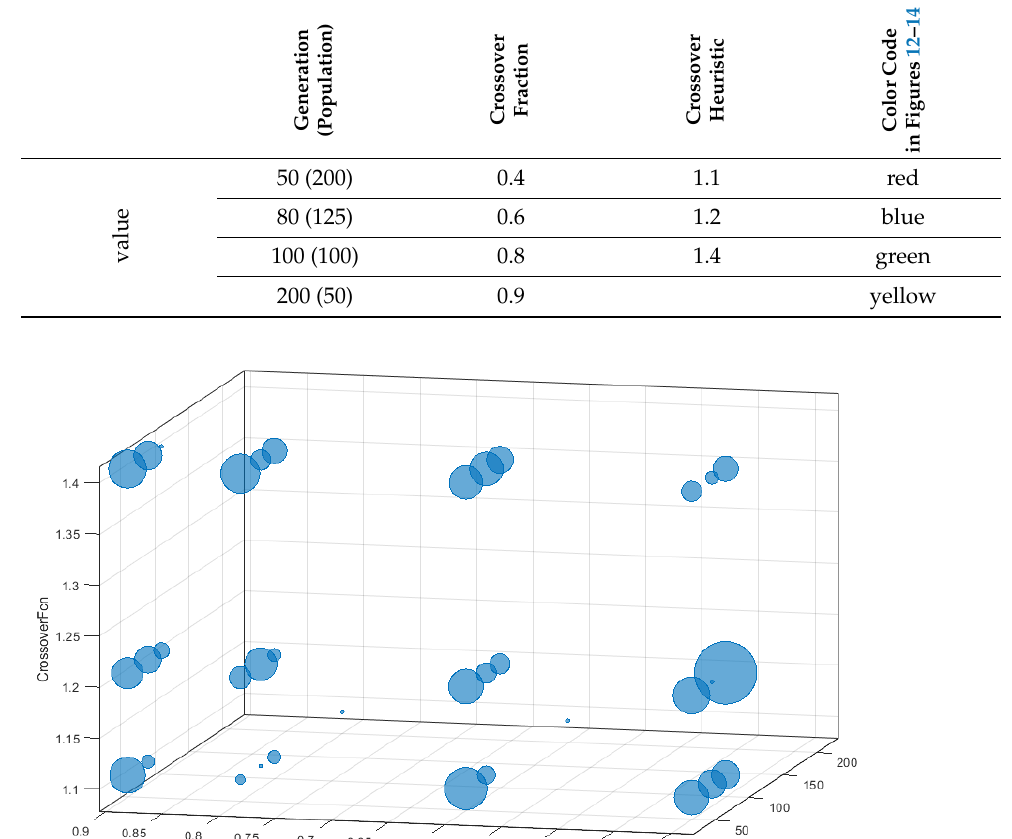
Table 6. Colour codes for figures.